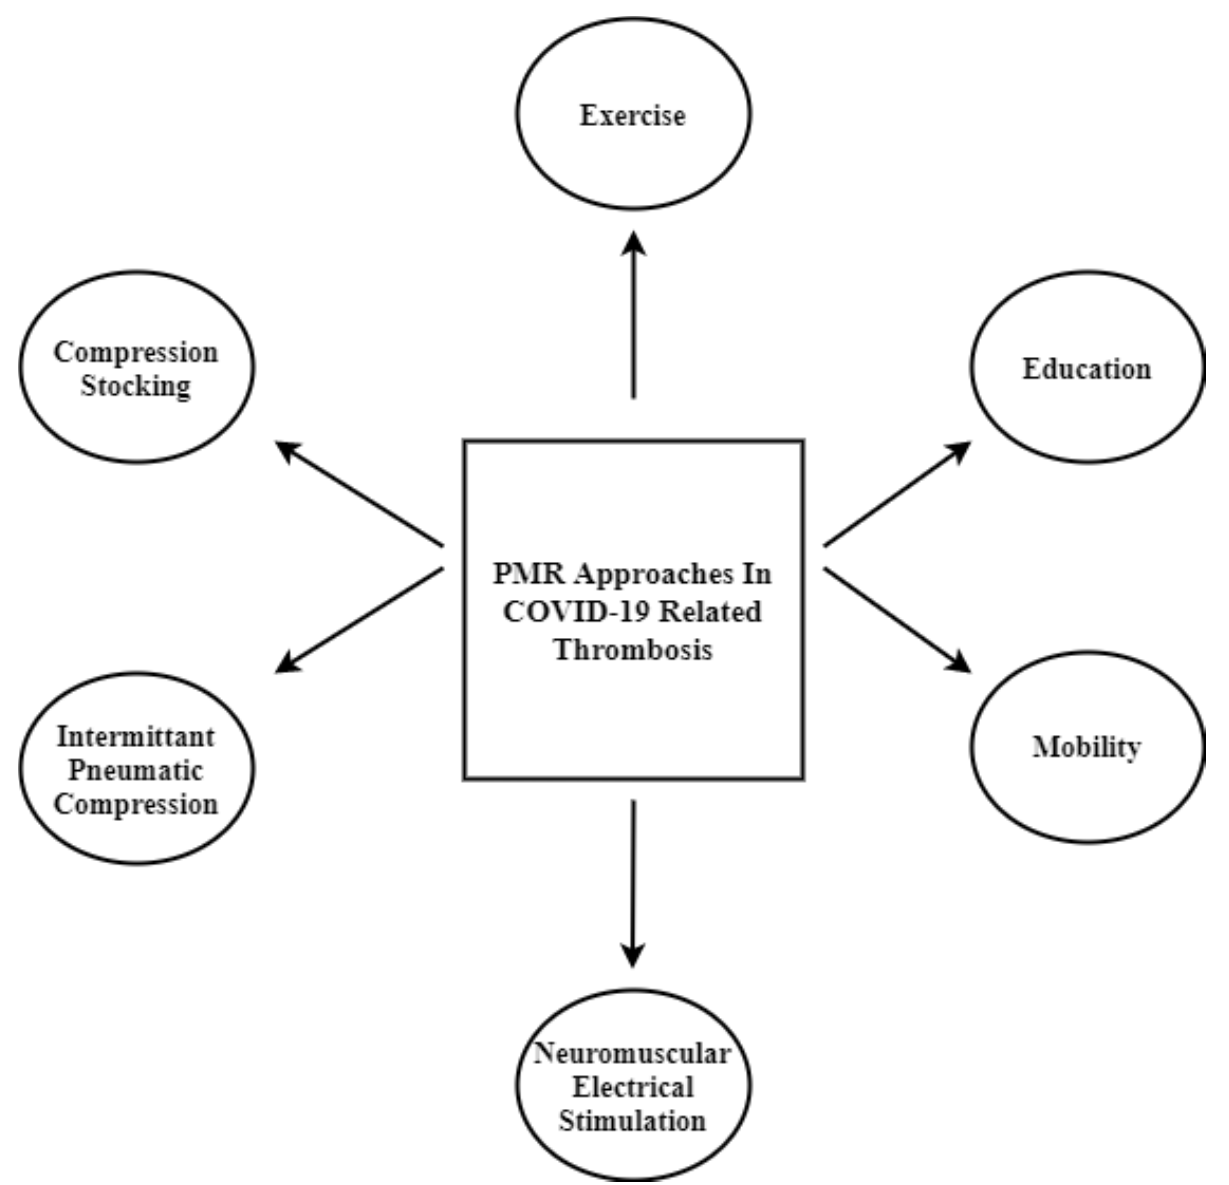
Figure 1. Physical Medicine and Rehabilitation Approaches In COVID-19 Related